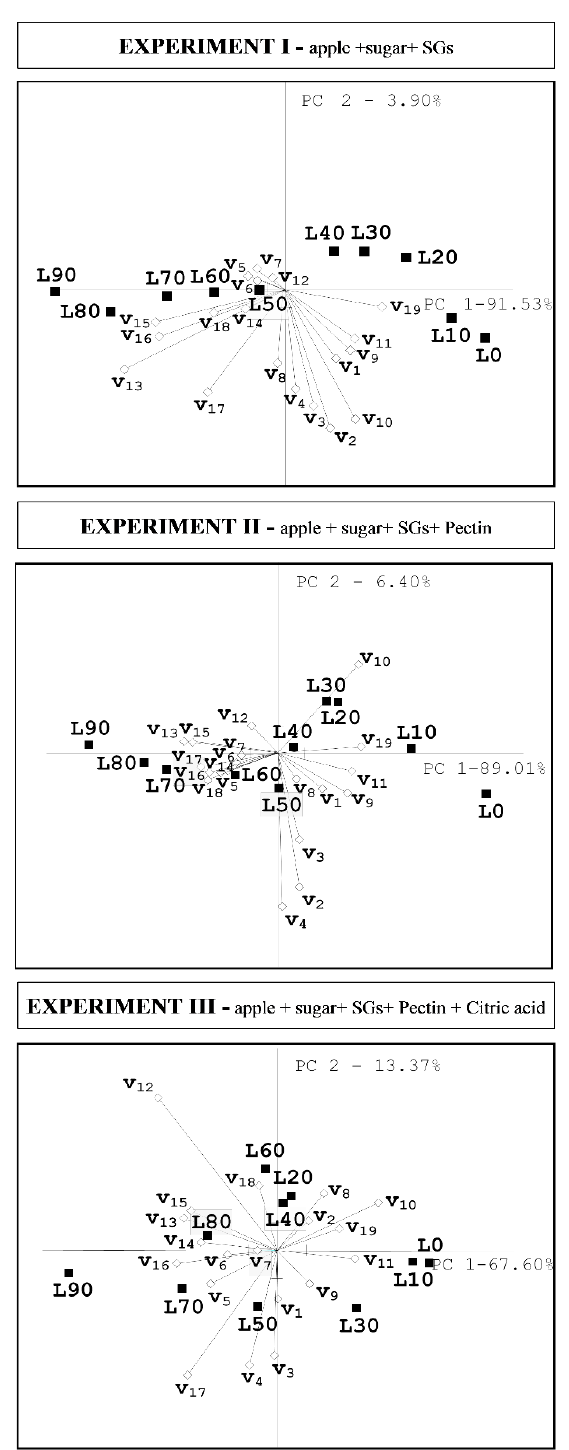
Figure 2. Principal components analysis (PCA) biplot of apple preserves’ sensory profiles. L0–L90— samples with 0%–90% SGs substitution; v 1 —apple o., v 2 —sweet o., v 3 —nectar o., v 4 —wine o., v 5 — metallic o., v 6 —sharp o., v 7 —other o., v 8 —color, v 9 —apple f., v 10 —sweet t., v 11 —nectar f., v 12 —sour t.,